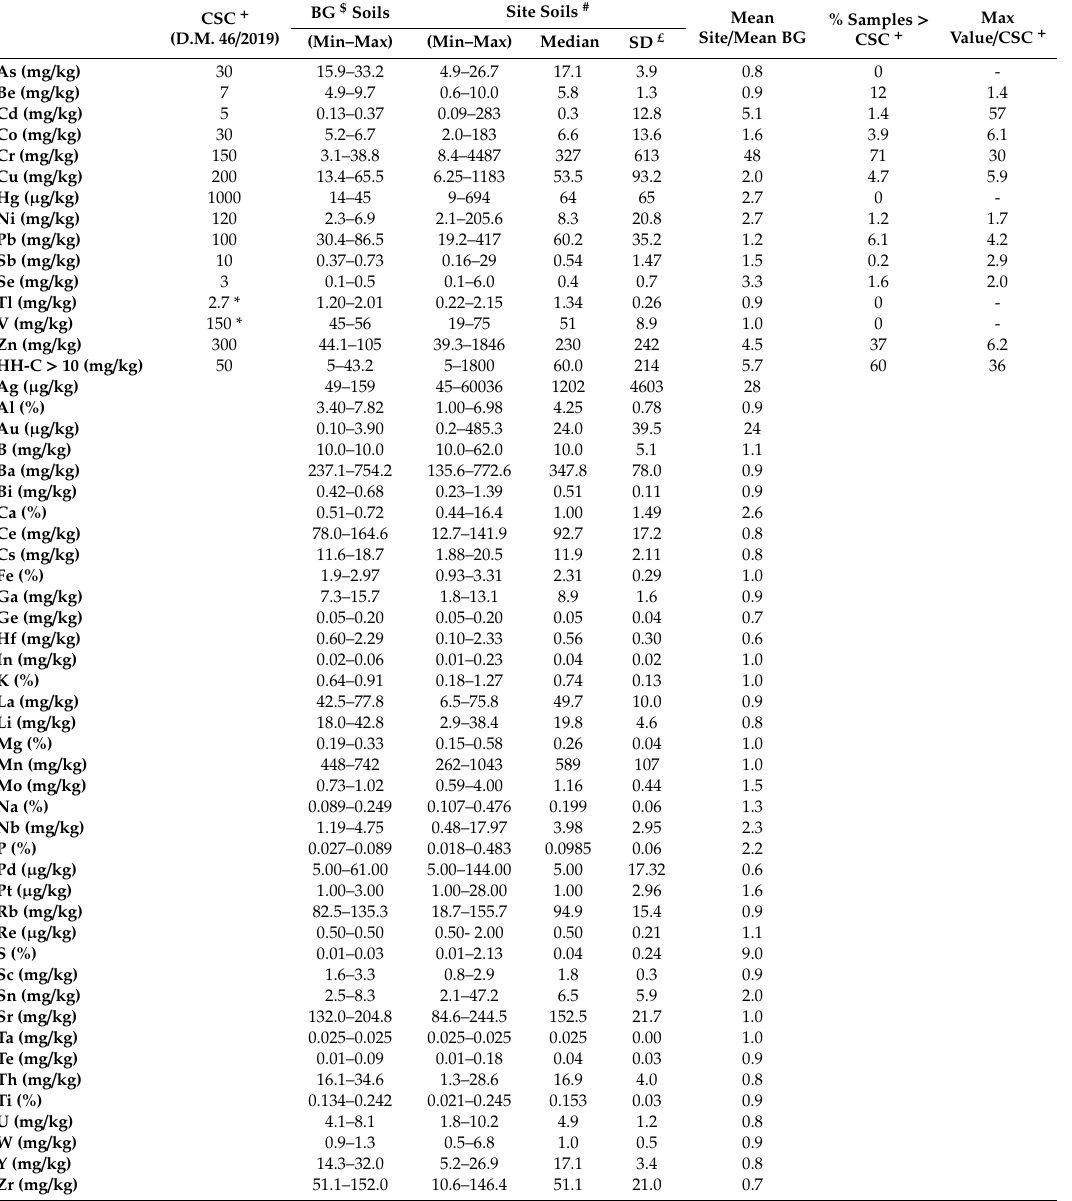
Table 1. Ranges of elements and heavy hydrocarbons (HH-C > 10) concentrations in the soil samples ( n = 507) in comparison with current Italian legal